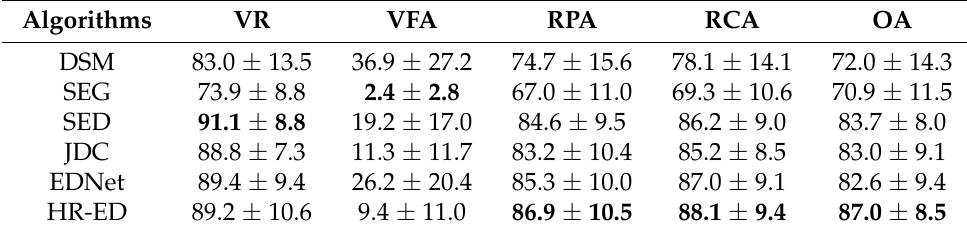
Table 4. Comparison of vocal melody extraction systems on ADC2004 datasets.